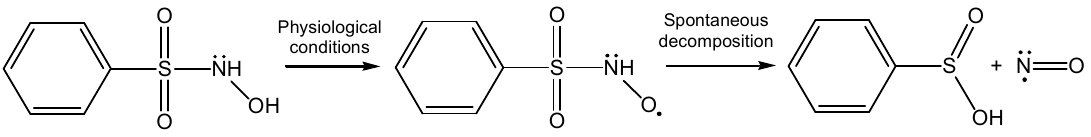
Scheme 2. Mechanism proposed for the decomposition of Piloty’s acid (PI) under physiological conditions.